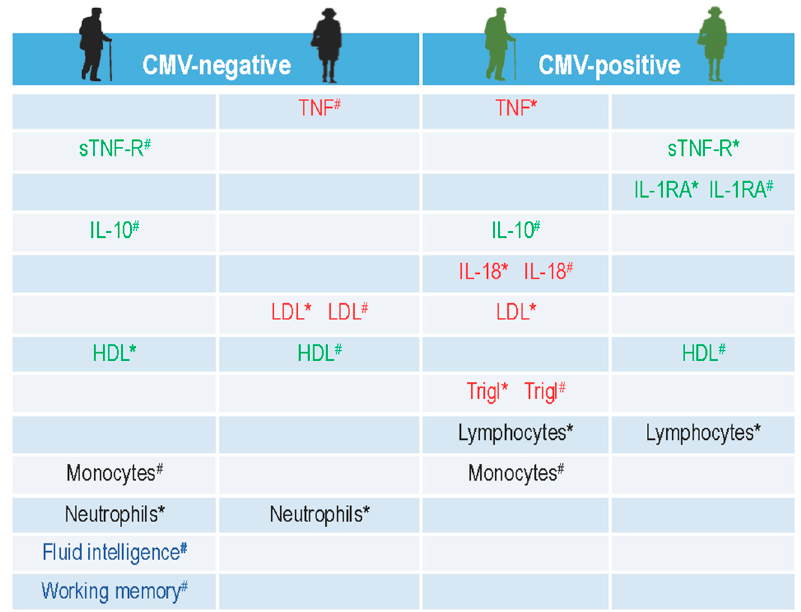
Figure 6. A schematic illustration of summarized results on the influence of gender and CMV-serostatus on circulating pro- and anti-inflammatory cytokines, receptor antagonist, metabolic factors, immune cells, and cognitive abilities in the baseline cohort of elderly participants. The names of the analyzed parameters with significantly higher values are placed in the corresponding column of the CMV-negative or CMV-positive men and women accordingly, whereby the notation ( # ) implies: a gender-related-higher value, and the notation (*) implies: a CMV-related-higher value. The pro-inflammatory mediators are written in red; the anti-inflammatory are green; the cognitive latent factors are blue; and immune cells are left in black. TNF: tumor necrosis factor; sTNF-R: soluble tumor necrosis factor receptor; IL: interleukin; IL-1 β : interleukin 1 beta; IL-1RA: interleukin 1 receptor antagonist; HDL: high-density lipoprotein; LDL: low-density lipoprotein.